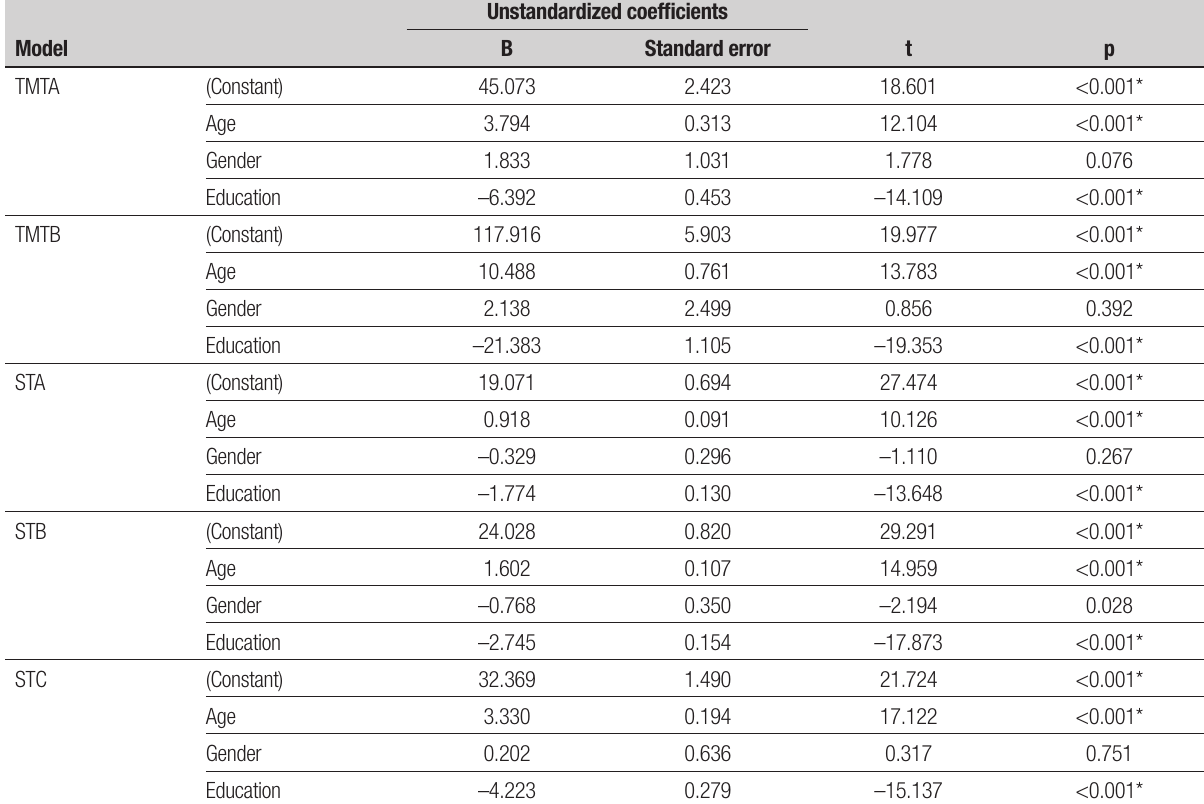
Table 2. Regression Model controlling for age, gender and education on attention tests.